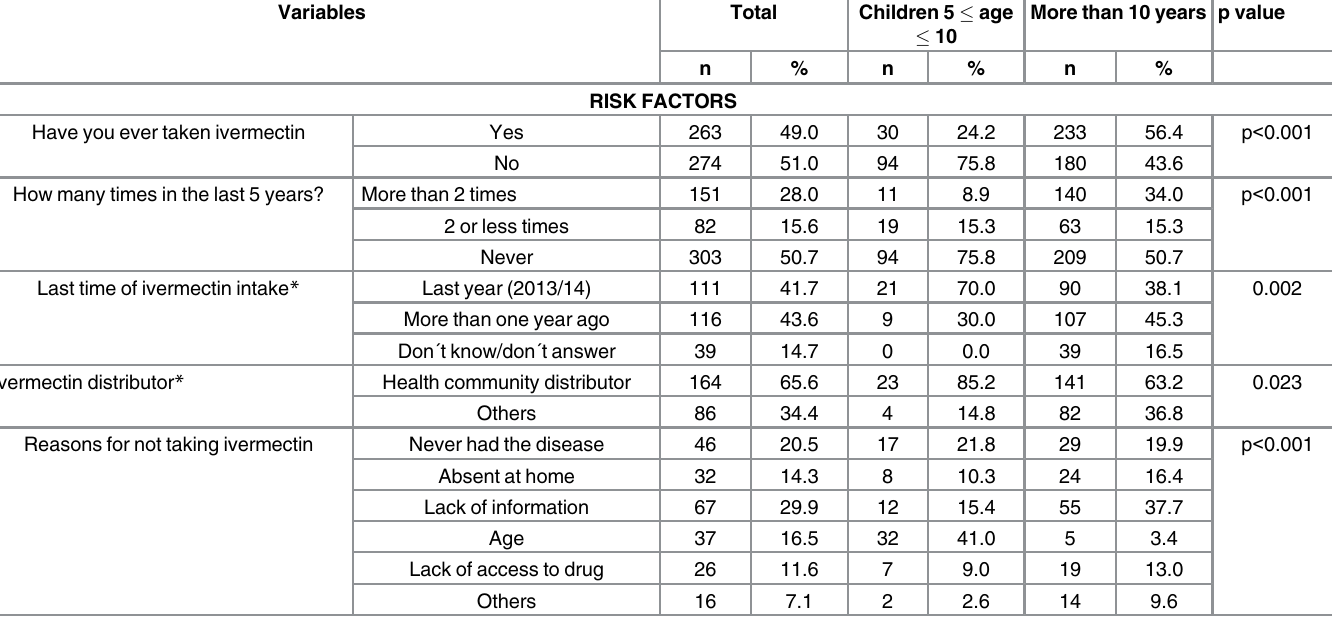
Table 4. Preventive treatment by age Bioko Island, Equatorial Guinea, January